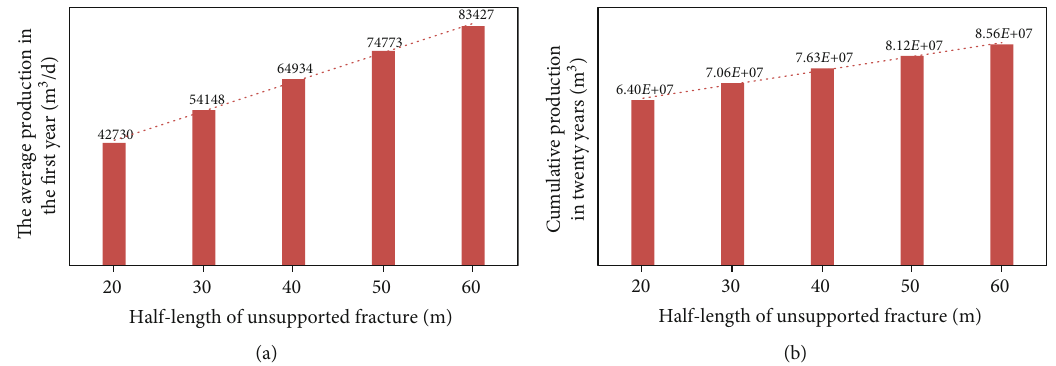
Figure 10: E ff ects of the half-length of supported fractures on gas production rate (a) and cumulative production (b).